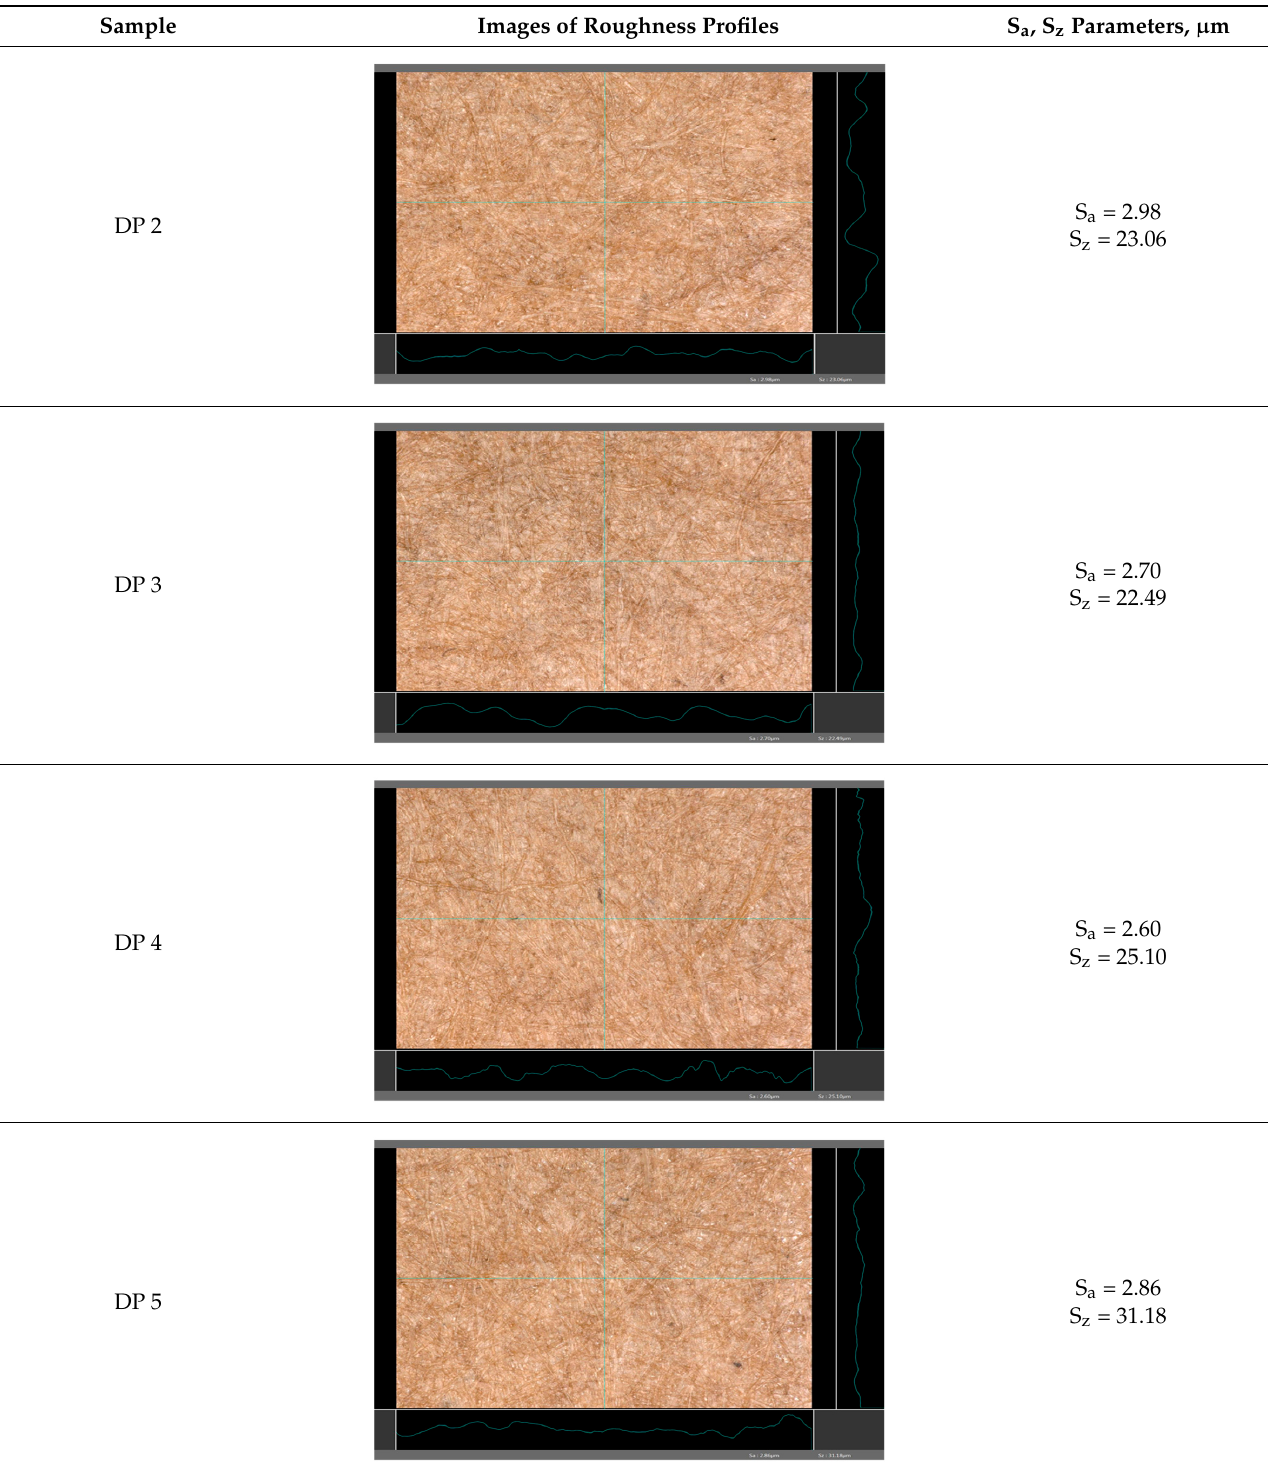
Table 5. Roughness profiles of the coated surface of the paper. DP—papers coated with paraffin- based dispersions, DB—papers coated with beeswax-based dispersions.